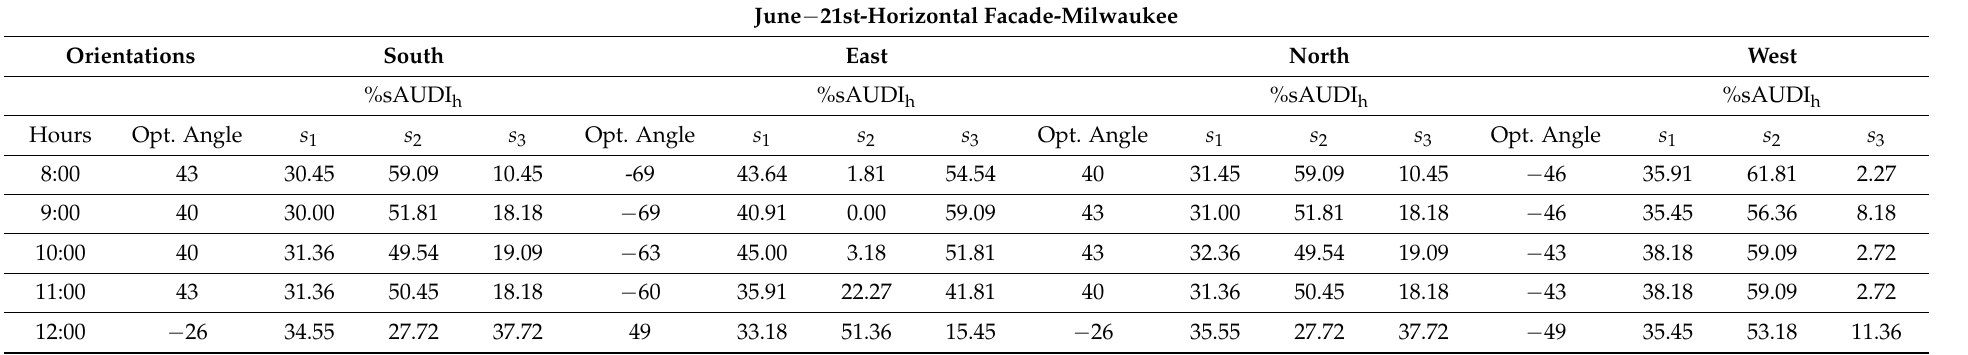
Table 10. The hourly optimum angles and their associated %sAUDI h on 21 June in Milwaukee-Horizontal louvers. June − 21st-Horizontal